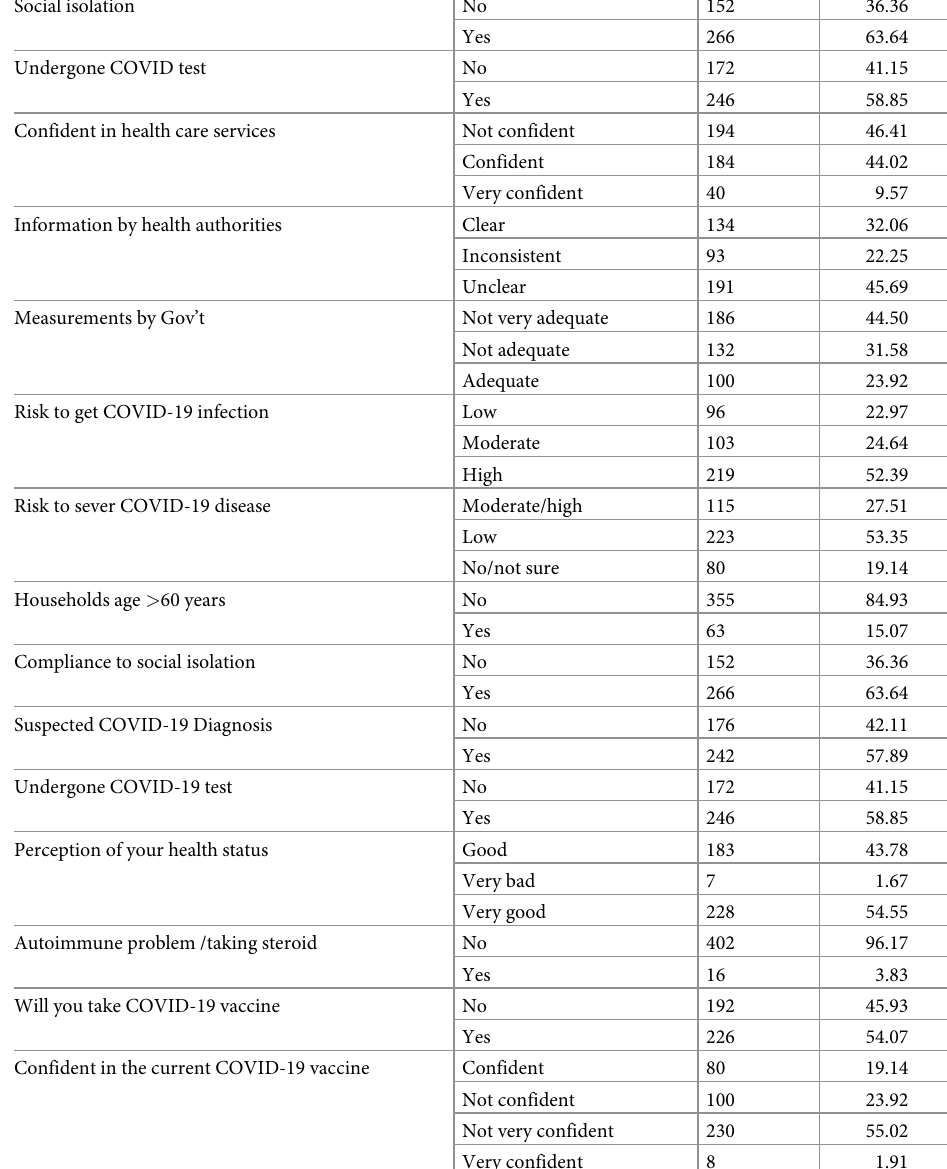
Table 2. COVID-19 related characteristics of the study participants (N = 418). Social